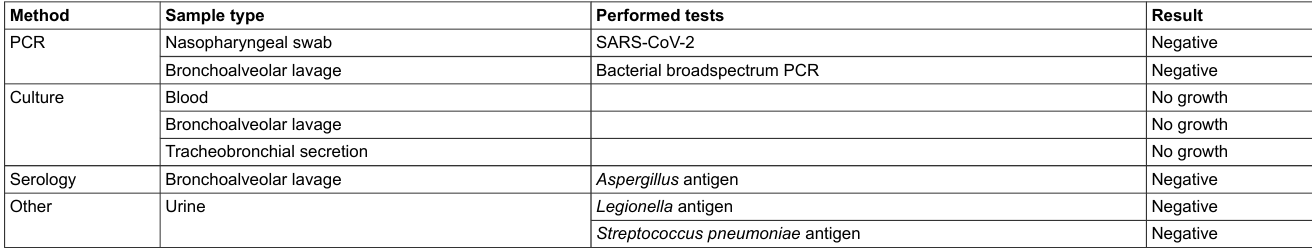
Figure S2: Patient 1: Computed tomography scan of the brain showing acute intraparenchymal bleeding in the right frontal lobe and generalised cerebral oedema.